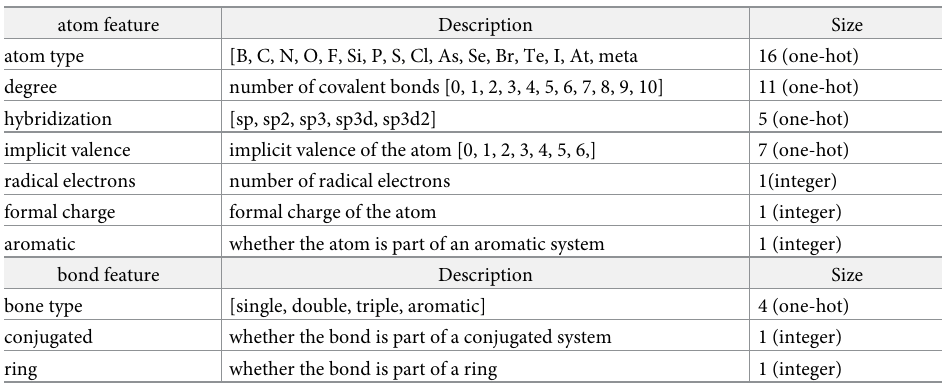
Table 3. Atom and bond